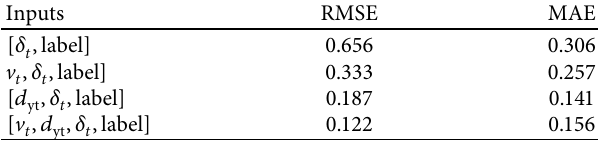
Table 11: Effect of inputs on model performance. Inputs RMSE